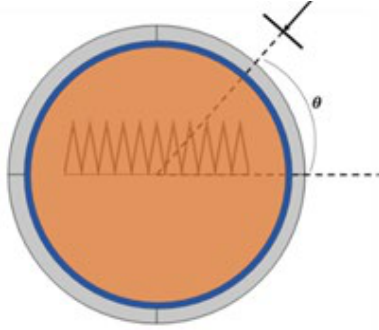
Figure 4. Three-dimensional radiation pattern.